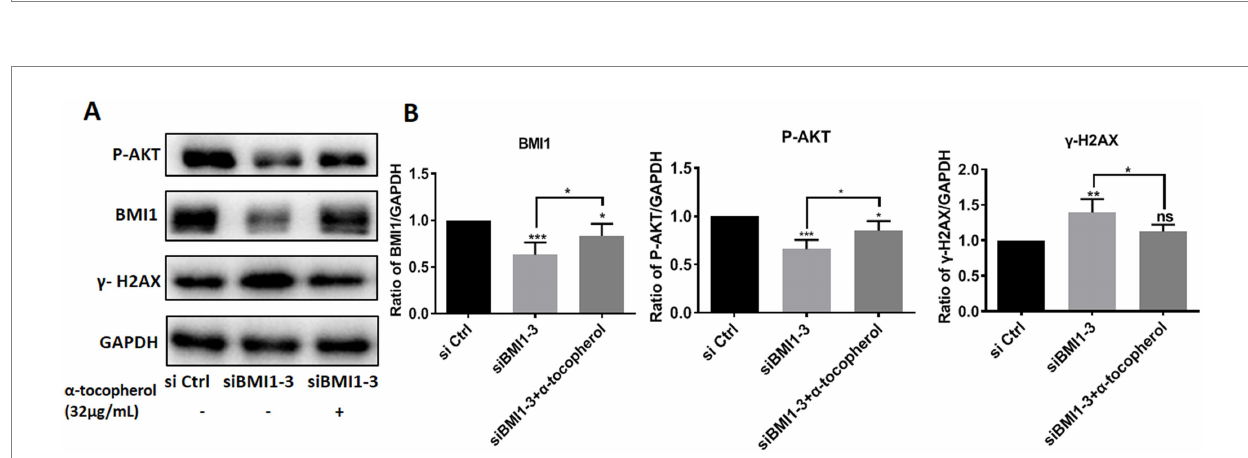
FIGURE 6 The efficacy of α -tocopherol on phos-AKT level and DNA damage in mouse SSCs caused by BMI1 silencing.